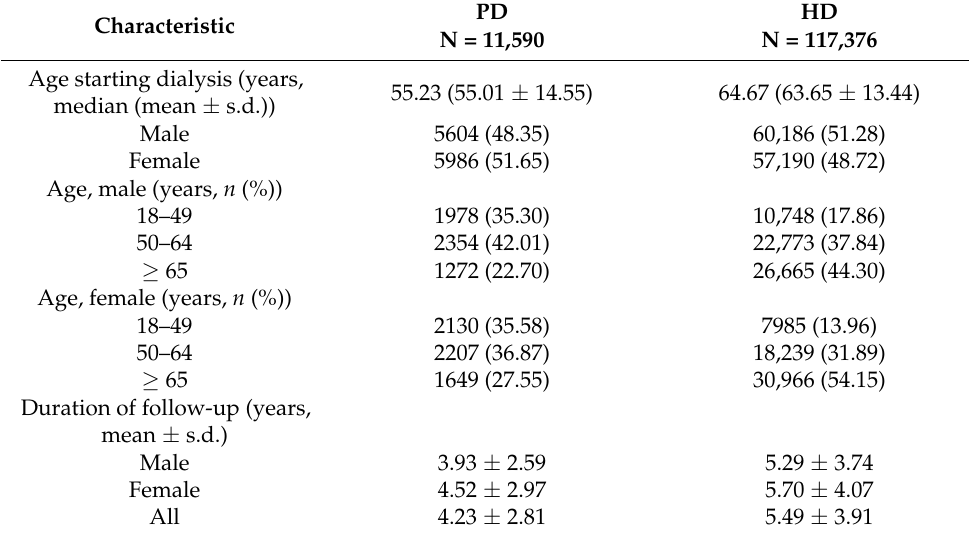
Table 1. Demographic characteristics of patients with end-stage renal disease by treatment status.